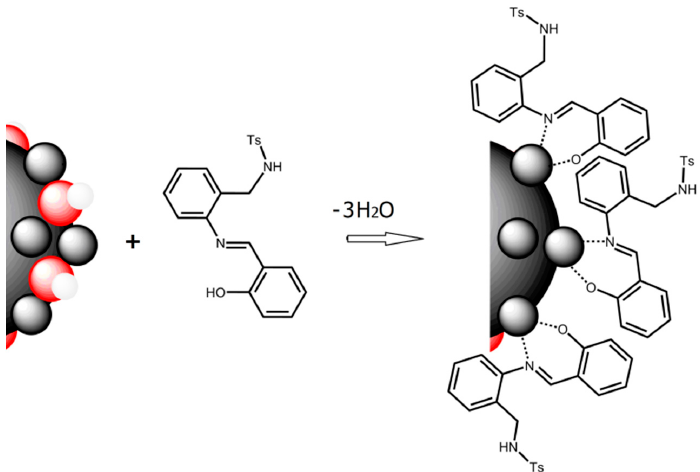
Figure 7. Schematic description of ligand exchange, which is the proposed sorption mechanism of H 2 SB (acting as bidentate chelating ligand) on the surfaces of CuO NPs (Cu 2+ ions are in grey and O 2 − are in red).